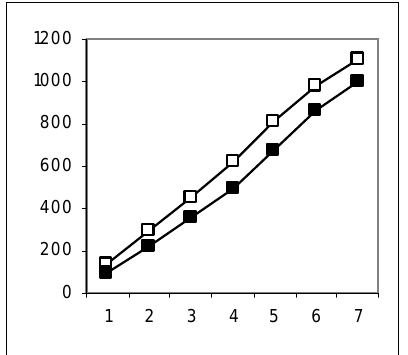
Figure 1. The effect on highland Rana temporaria, added from the two-legged stage on; pooled data from 1990 and 2000 [7-9]. Ordinate = cumulative frequency of 4- legged tadpoles (N). Abscissa = points in time. Black squares = frequencies of animals treated with homeopathically prepared thyroxin; white squares = of animals treated with analogously prepared